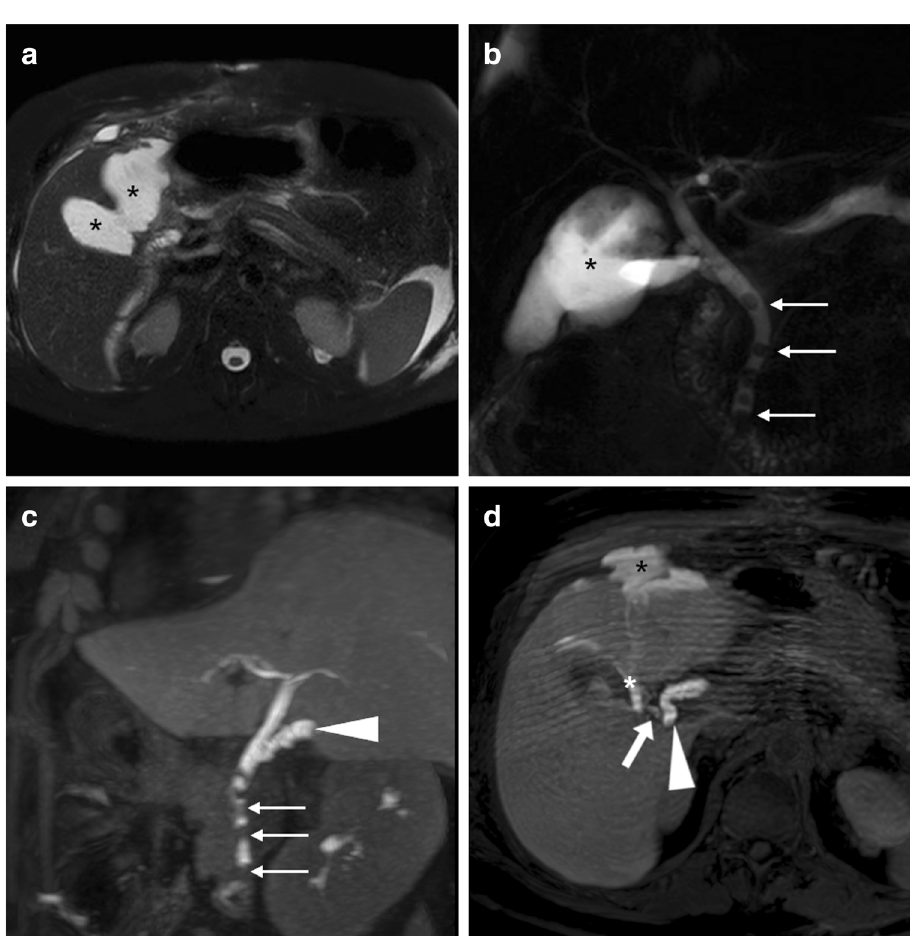
Fig. 19 On the 7th postoperative day after laparoscopic cholecystectomy, urgent MR including fat-saturated T2- weighted ( a ) and MRCP ( b ) showed sizeable biloma (*) ex- tending ventrally from the gall- bladder fossa, some peritoneal fluid and mildly dilated CBD containing multiple millimetric filling defects consistent with stones ( thin arrows in b ). Gadoxetic acid-enhanced MRCP confirmed residual choledocholi- thiasis ( thin arrows in c ) and allowed detecting a small biliary leak ( arrow in d ) from the cystic duct remnant ( arrowheads ), causing opacification of the biloma (*). Endoscopic treatment included sphincterotomy and